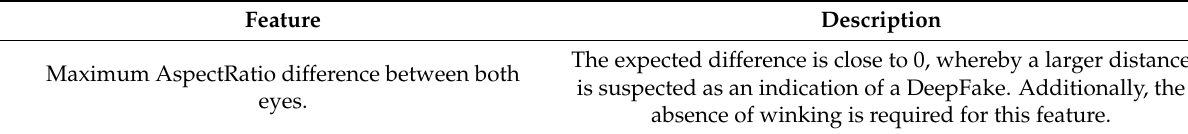
Table A1. Collection of all features and their expected behaviors proposed in this